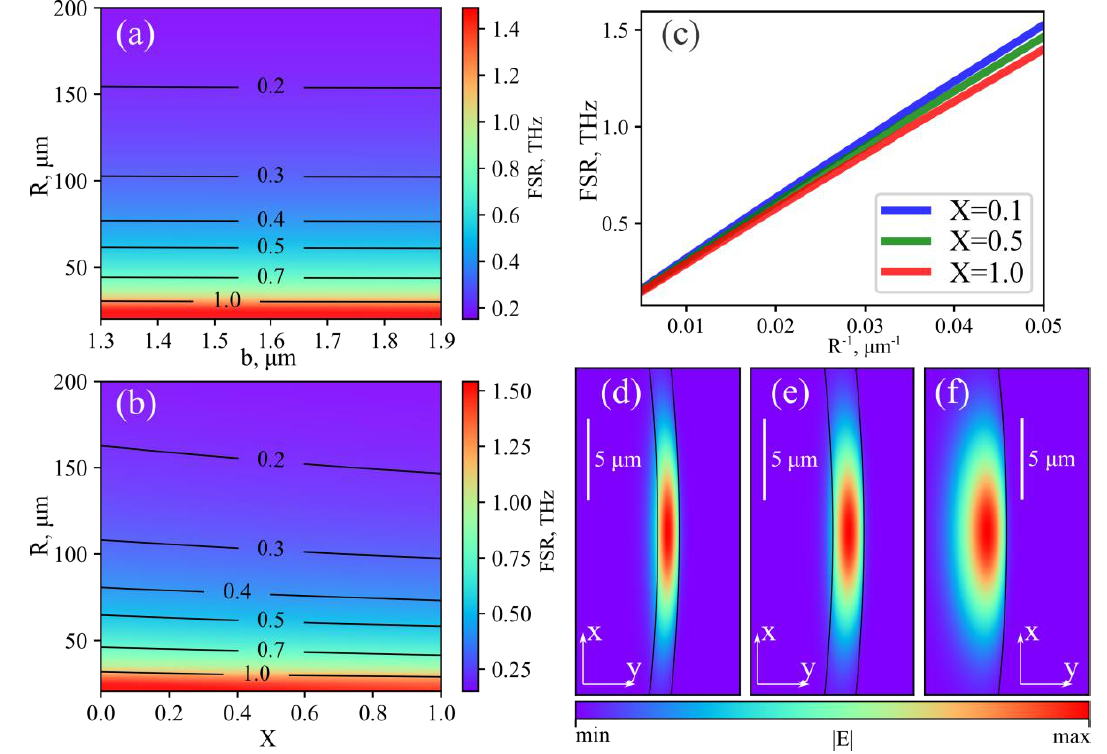
Figure 5. ( a ) Calculated FSR as a function of b and R for X = 0.5; ( b ) Calculated FSR as a function of X and R ; ( c ) Calculated FSR as a function of R −1 for different X ; ( d – f ) Electric field absolute value distribution for microresonators with X = 1.0, R = 100 μm, and b = 1.3 μm ( d ), b = 1.9 μm ( e ), and regular GeO 2 microsphere of R = 100 μm ( f ).